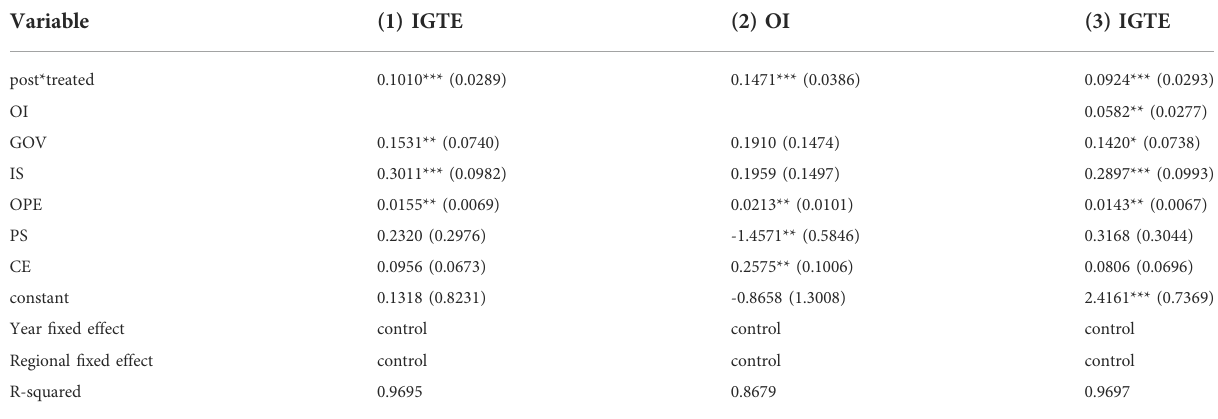
TABLE 10 Mediating effect of the overall innovation level of enterprises.